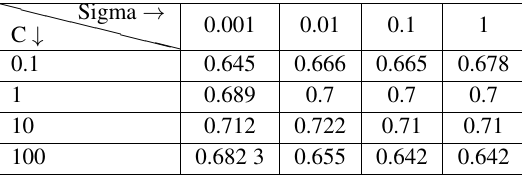
Table 5. Performance of SVR in terms of RMSE